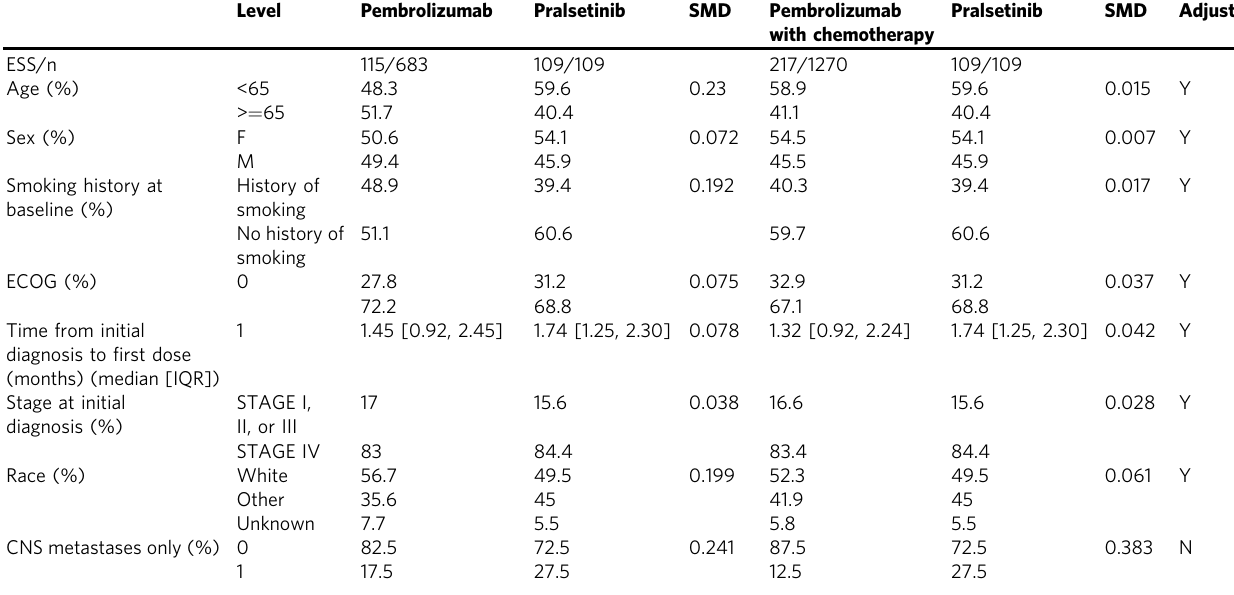
Table 3 Baseline characteristics of the 1 L ARROW trial participants given pralsetinib and Flatiron EDM cohort given 1 L pembrolizumab, and 1 L pembrolizumab with chemotherapy after IPTW-adjustment; balanced variables are those with SMD <